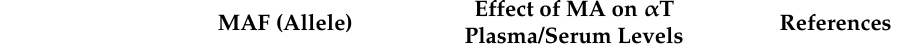
Table A2. Genetic variations associated with α -tocopherol ( α T) with and without supplementation as well as with treatment response in NAFLD. The minor allele frequency (MAF) given has been obtained from the ALFA project in the dbSNP database. Only variations with a MAF of at least 5% are included in this review. * indicates genes involved in splicing and not discussed in this